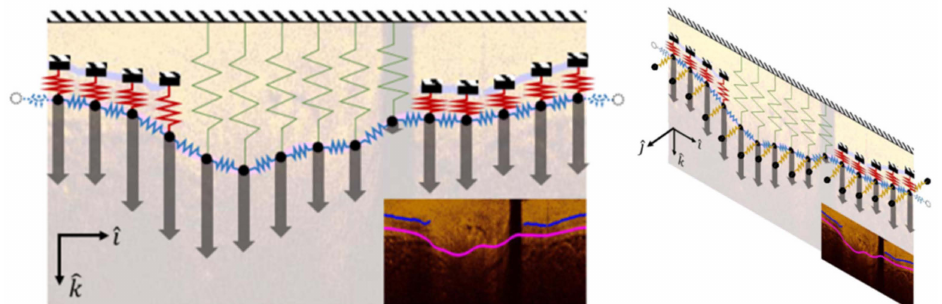
Figure 7. Outline of the surface fitting technique using four different spring stiffnesses (blue, green, yellow, and red) fitted either to visible sections of the outer elastic membrane or the detected lumen contour. Nodes (black circles) were connected to adjacent nodes within the image frame as well as both proximal and distal frames. Gray arrows represent the applied forces proportional to the sum of A-line pixel intensities. The surface fitting and force-balance optimization was carried out across the entire pullback ( j direction) to generate a smooth and continuous outer wall over the entire artery section. © [2019] IEEE. Reprinted, with permission, from